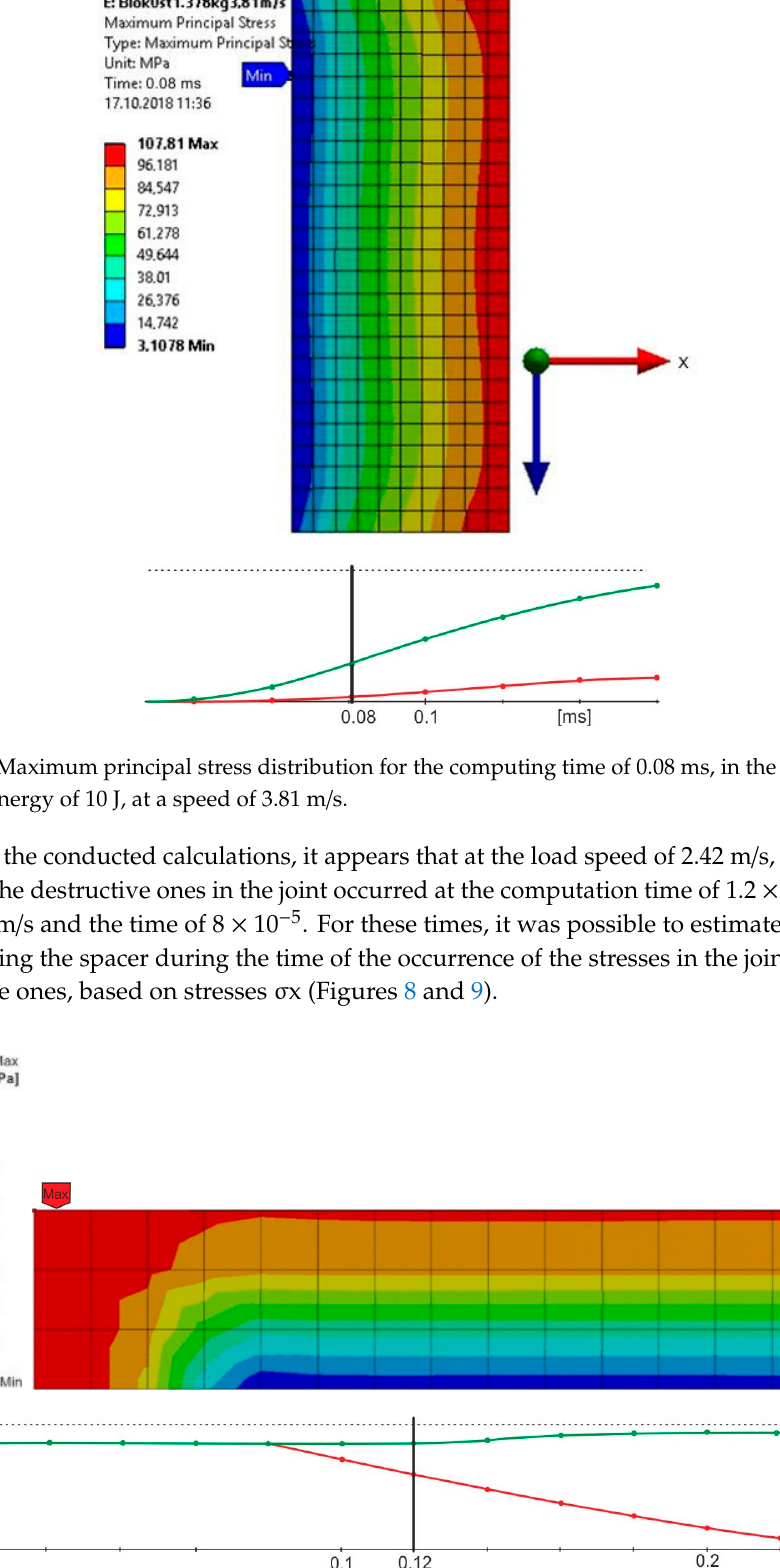
Figure 6. Maximum principal stress distribution for the computing time of 0.12 ms in the joint, loaded with energy 10 J, at a speed of 2.42 m/s .